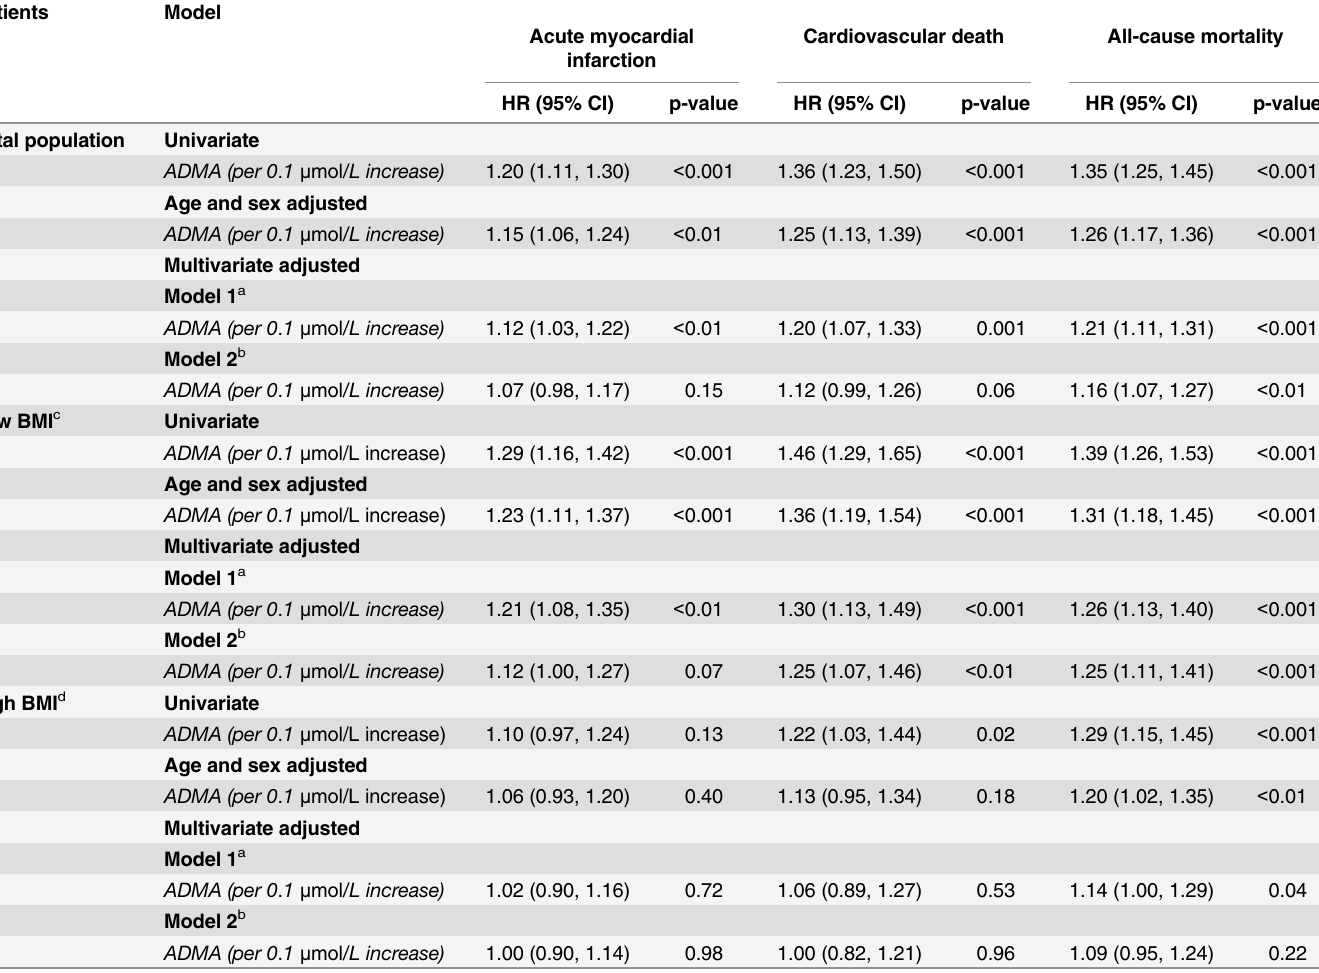
Table 2. Risk of acute myocardial infarction, cardiovascular death and all-cause mortality according to plasma ADMA levels in the total population and in patients with high or low BMI.